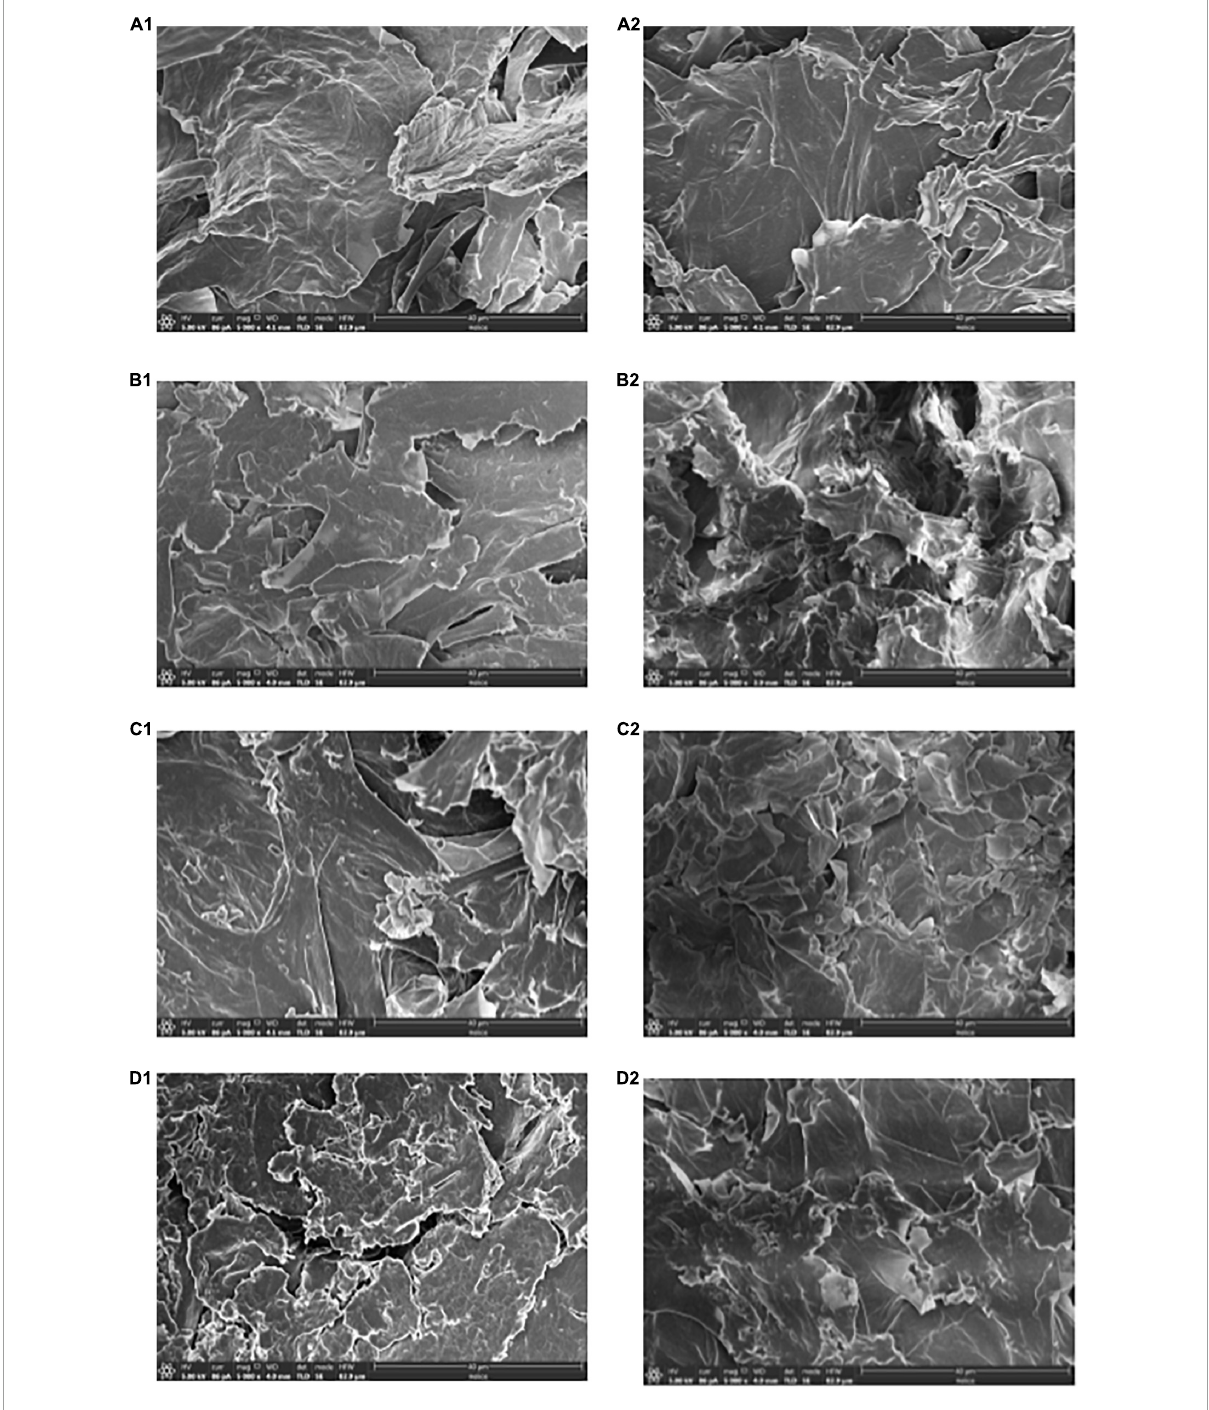
FIGURE4 SEM images of Pleurotus eryngii chips before frying (A1–D1) and after frying (A2–D2) : (A) Blanching; (B) Blanching + osmosis; (C) Blanching + ultrasound; (D) Blanching + ultrasound + osmosis.